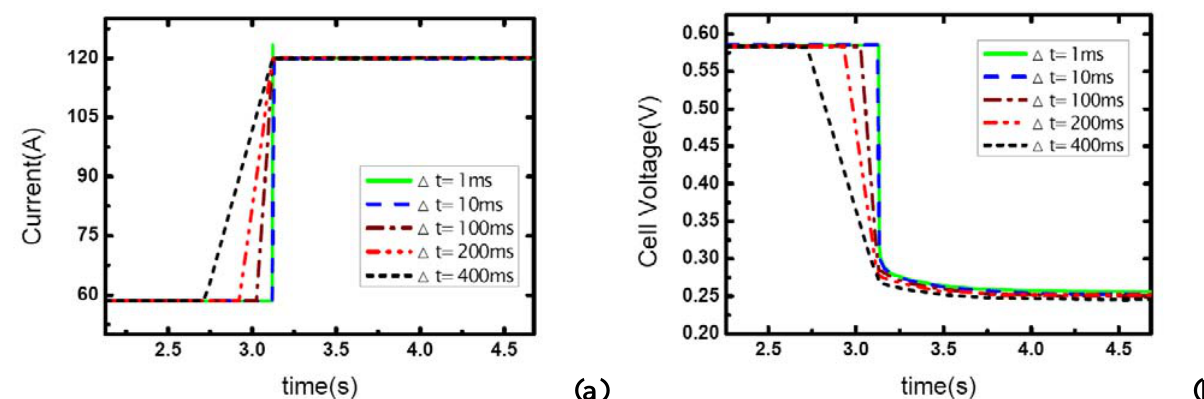
Figure 5. (a) Current change as five different step rates while λ (b) corresponding dynamic responses of voltage.